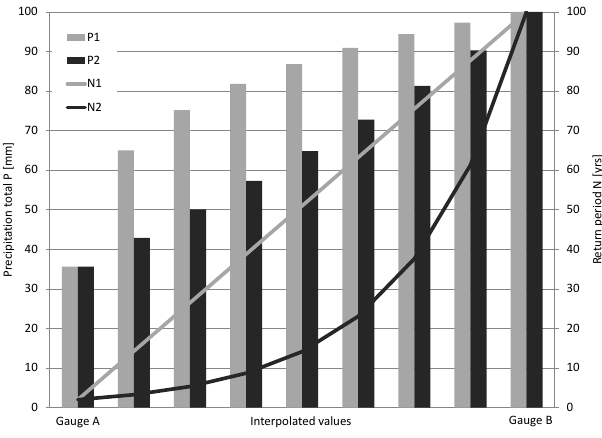
Fig. 8. Precipitation totals ( P) between two gauges, calculated from differently interpolated return period values ( N) : (1) linear inter- polation of return periods, and (2) linear interpolation of common logarithms of return